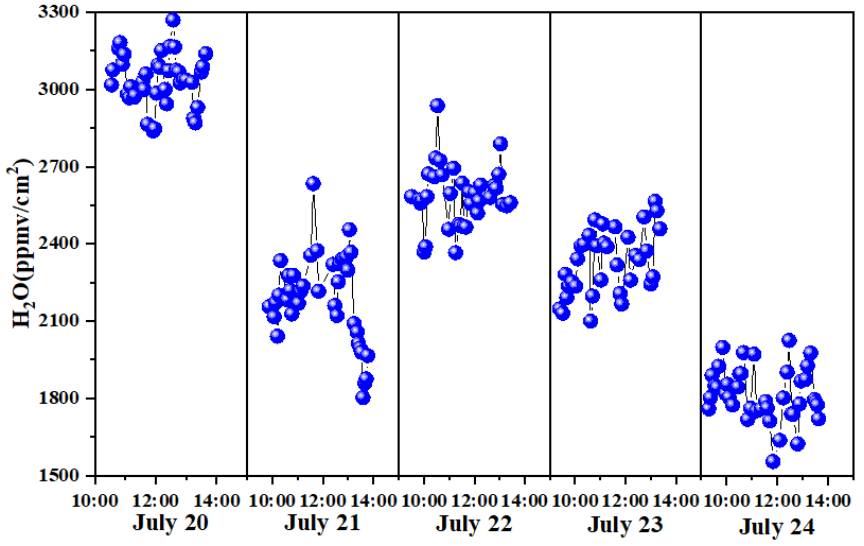
Figure 9. Water vapor column densities at Dunhuang.